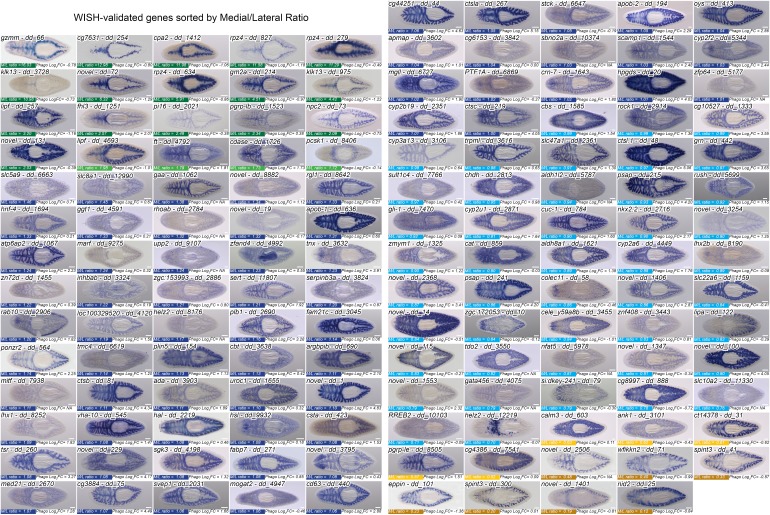
Expression of transcripts enriched in laser-captured intestinal tissue.Whole-mount in situ hybridizations performed during this study, organized by mediolateral ratio. 144/162 total in situs conducted are shown (18 omissions were due to very low or no detectable expression; helz2/dd_12219 was detected only in peripharyngeal cells). Each image also shows the phagocyte enrichment value (Log2FC), as well as the Uniprot best hit ID and the Dresden v6 Transcriptome GeneID (dd_Smed_v6). Several transcripts are named to be consistent with previous publications (hnf-4/dd_1694, PTF1A/dd_6869, gli-1/dd_7470, slc22a6/dd_1159), with human Uniprot IDs used in our comparison to the Human Protein Atlas (sult1c4/dd_7766, tdo2/dd_3550), or to distinguish paralogs (apob-1/dd_636, apob-2/dd_194). Detailed gene ID information is available in Supplementary file 1. Scale bars, 200 μm.